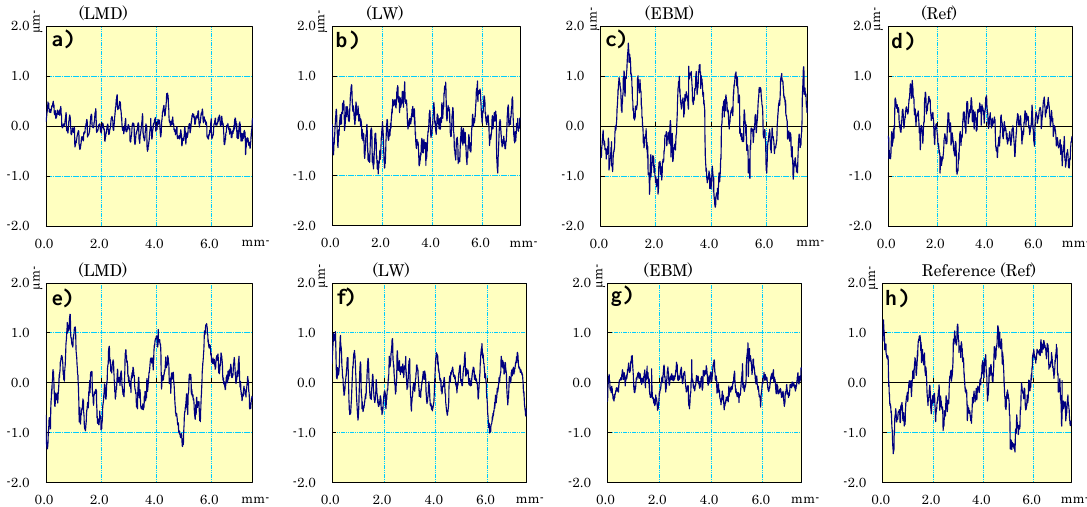
Figure 11. ( a – d ) Profilometry measurements conducted in the machining direction in the IJ-plane. The samples were machined in the I-direction. ( e – h ) Profilometry measurements conducted in the machining direction in the IJ-plane. The samples were machined in the J-direction.